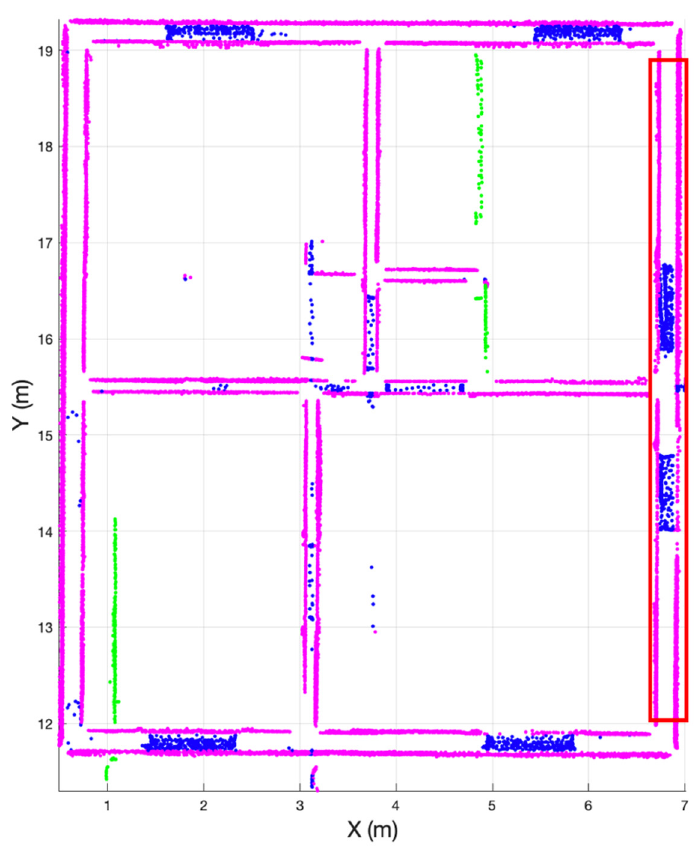
Figure 6. Signal House door and window candidates in their search space; walls in magenta, door and window candidates in blue, and walls with no neighbours in green. Red box outlines the door and window candidate points displayed in Figure 7.